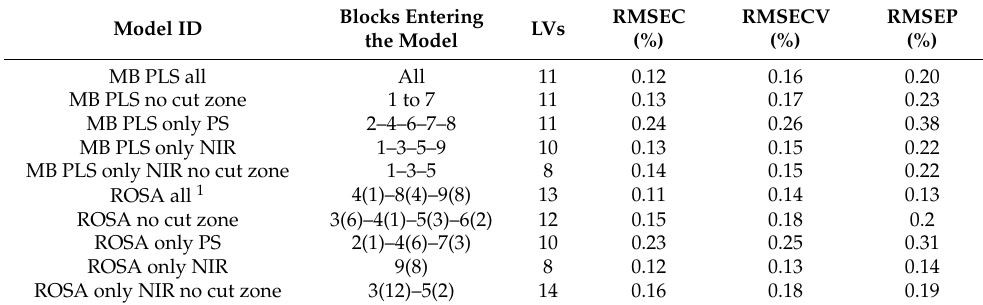
Table 2. Results yielded by MB-PLS and ROSA for the prediction of Property